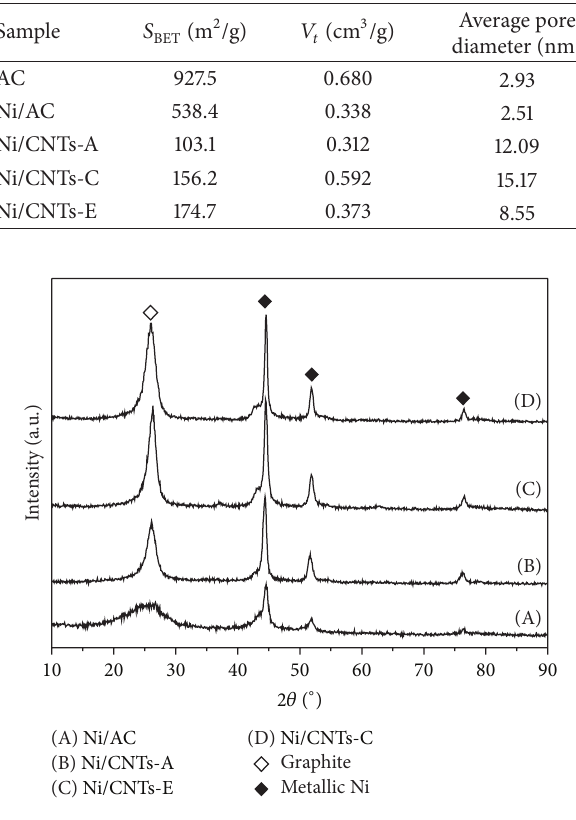
Figure 4: XRD profiles for the reduced catalysts.